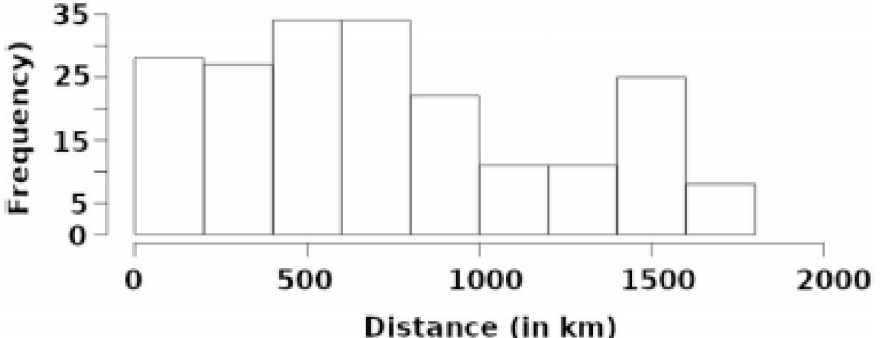
Figure 7. Distance between typhoon observed and simulated